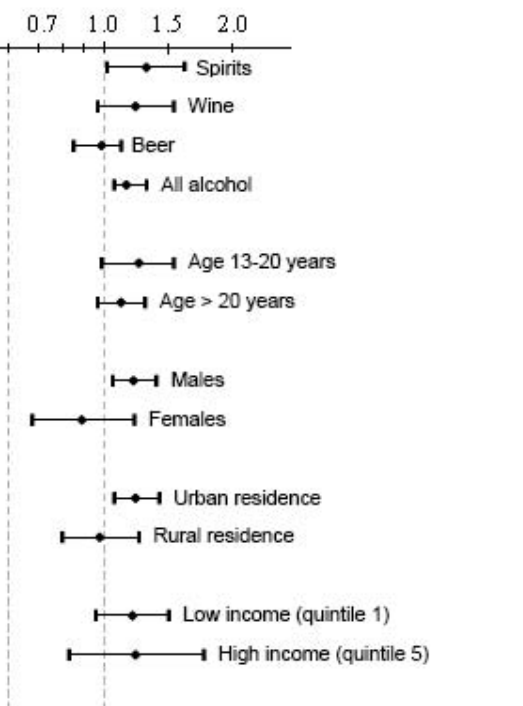
Figure 2. Risk of Hospitalization for Assault per 1,000 l Increase in Daily Alcohol Sales, According to Alcohol Type and Patient Variables